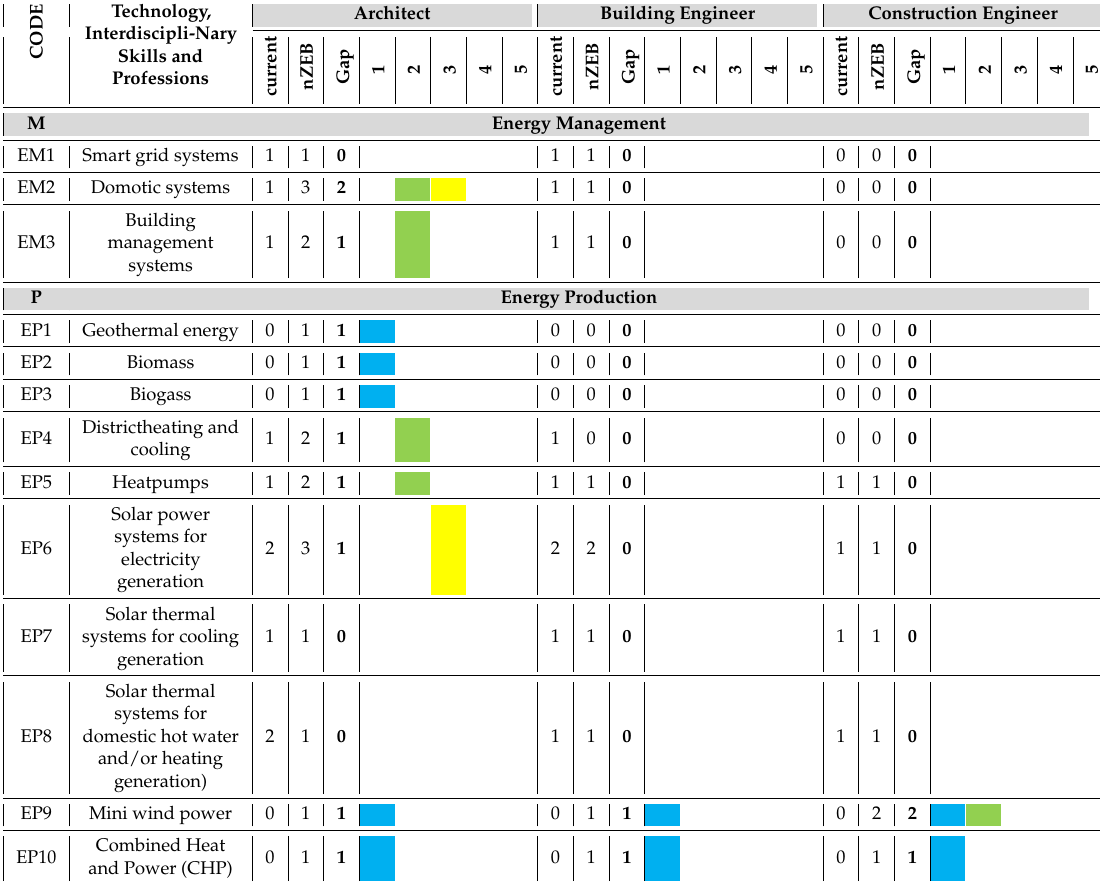
Table 4. PROF/TRAC skills mapping result for the Netherlands,